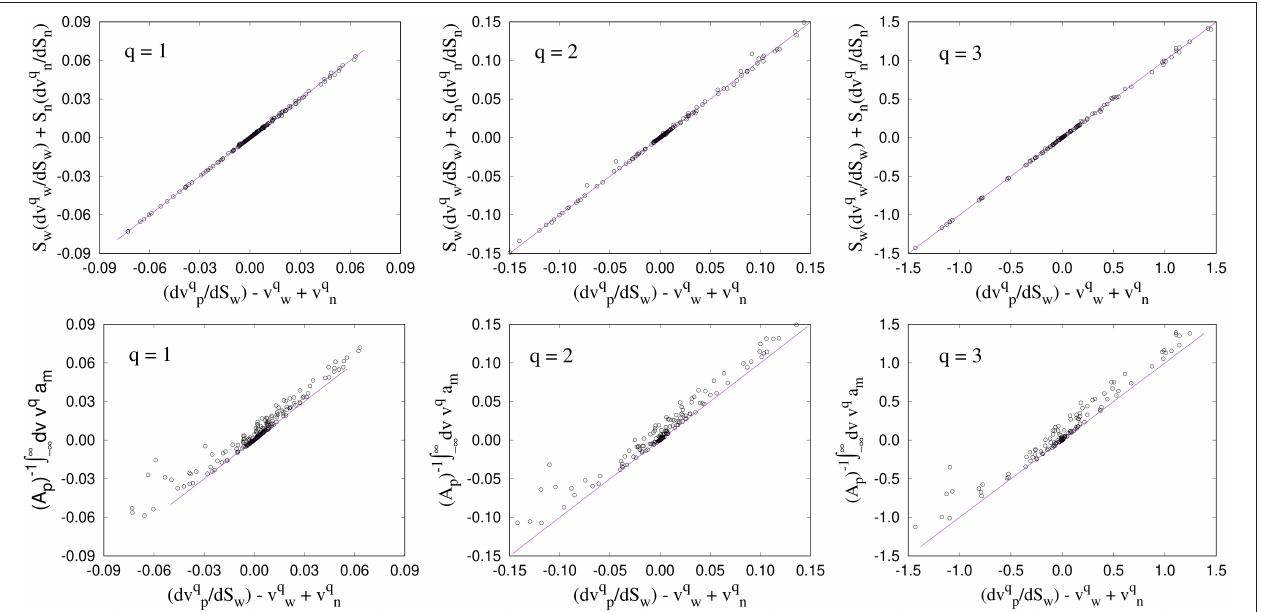
FIGURE 4 | Measurement of the co-moving velocity ( v m ) and its higher moments for the 2D network. The top row corresponds to the calculations using Equations (29) and (30) with the direct measurements. The bottom row shows the measurements of v q m using the differential area distributions with Equation (46) and compared with the direct measurements where higher fluctuations are observed. v m has a unit mm/s. Subsequently, for q respectively.